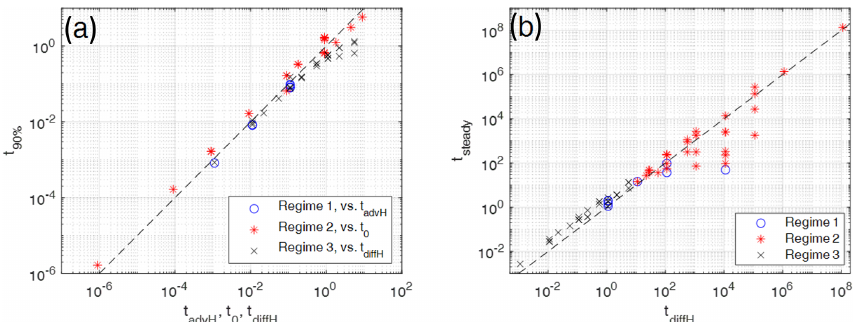
Figure 10. For evaluating timescales the numerically determined times of models with various parameters Pe and G representing the three different regimes 1, 2, and 3 (different symbols) are plotted against characteristic scaling times. (a) Times for reaching 90% of the maximum temperature difference (cid:49)T max are plotted against either the advective timescale t advH based on model height H for regime 1 models or against the scaling time t 0 for regime 2 models, or against the diffusive timescale t diffH based on the model height H . (b) Times for reaching steady states are plotted against the characteristic diffusive timescales, t diffH , based on model height H for all three regimes. Models close to the dashed line ( y = x ) are in best agreement with the characteristic times. In (a) regime 2 times are taken dimensionally by multiplying = 1 by some arbitrary dimensional times t the observed times and the non-dimensional scaling time t (cid:48) 0 . 0 c. > 10 5 for the dike